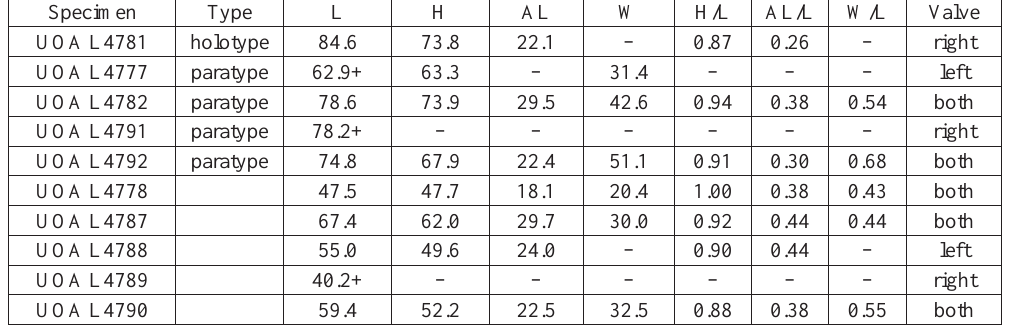
Table 1. Measurements (in mm) of Meganodontia haunuiensis sp. nov. Abbreviations: AL, anterior length; H, height; L, length; W, width.